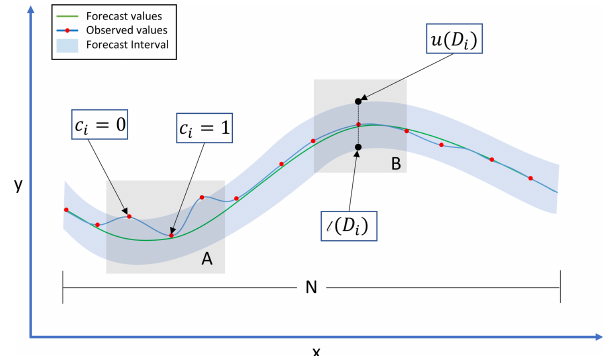
Figure 3. A diagram illustrating how the prediction interval cov- erage probability (PICP) (a) and the mean prediction interval width (MPIW) (b) are computed.